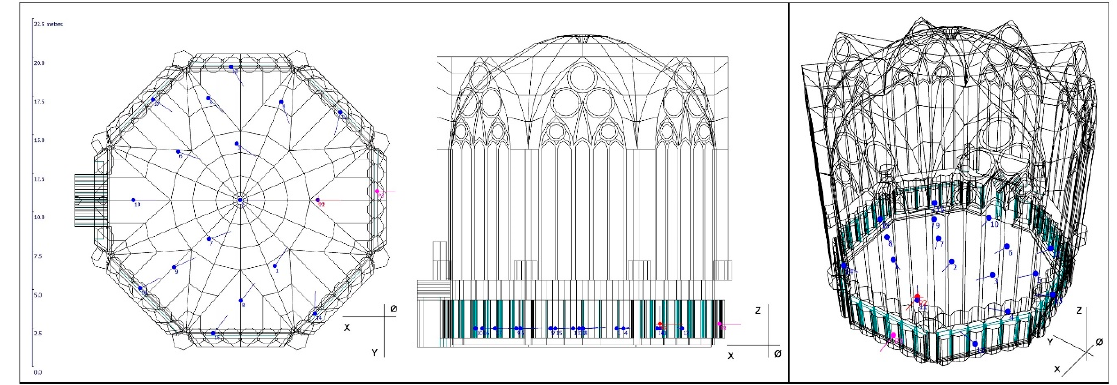
Figure 7. York Minster’s Chapter House simulation model views.